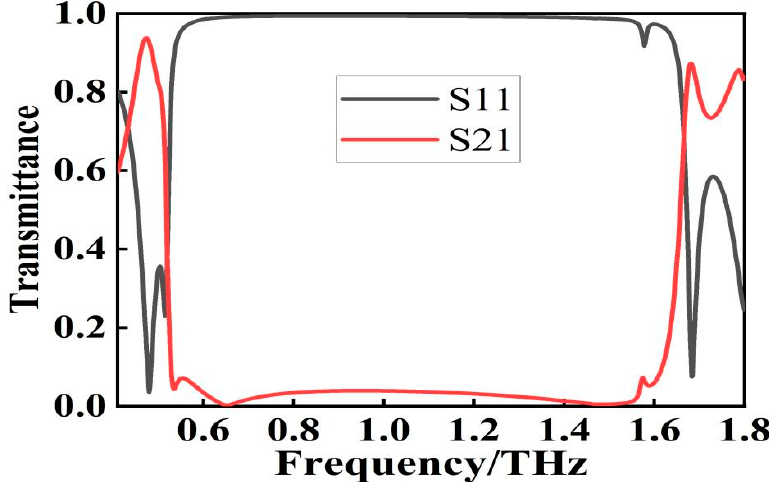
Figure 2. Transmittance spectrum of MDMDM structure.